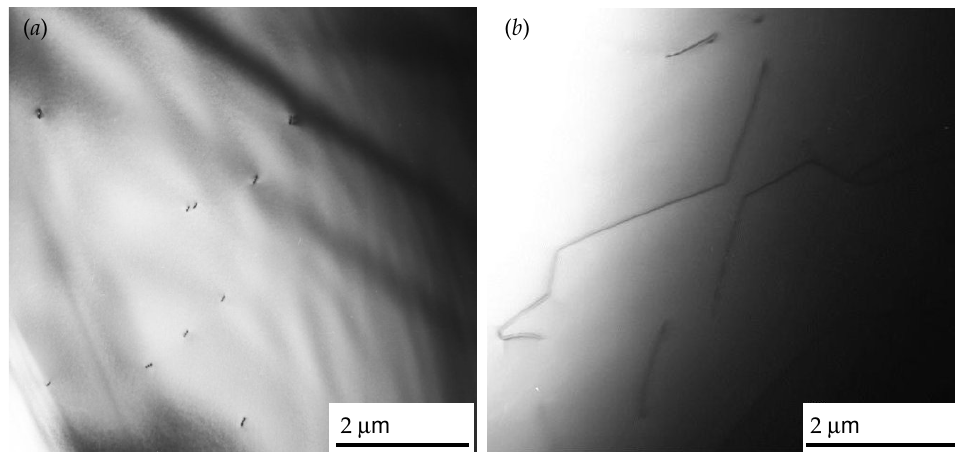
Figure 6. Plan view TEM image (zone axis) of threading dislocations ( a ) and dislocations in the basal plane ( b ).